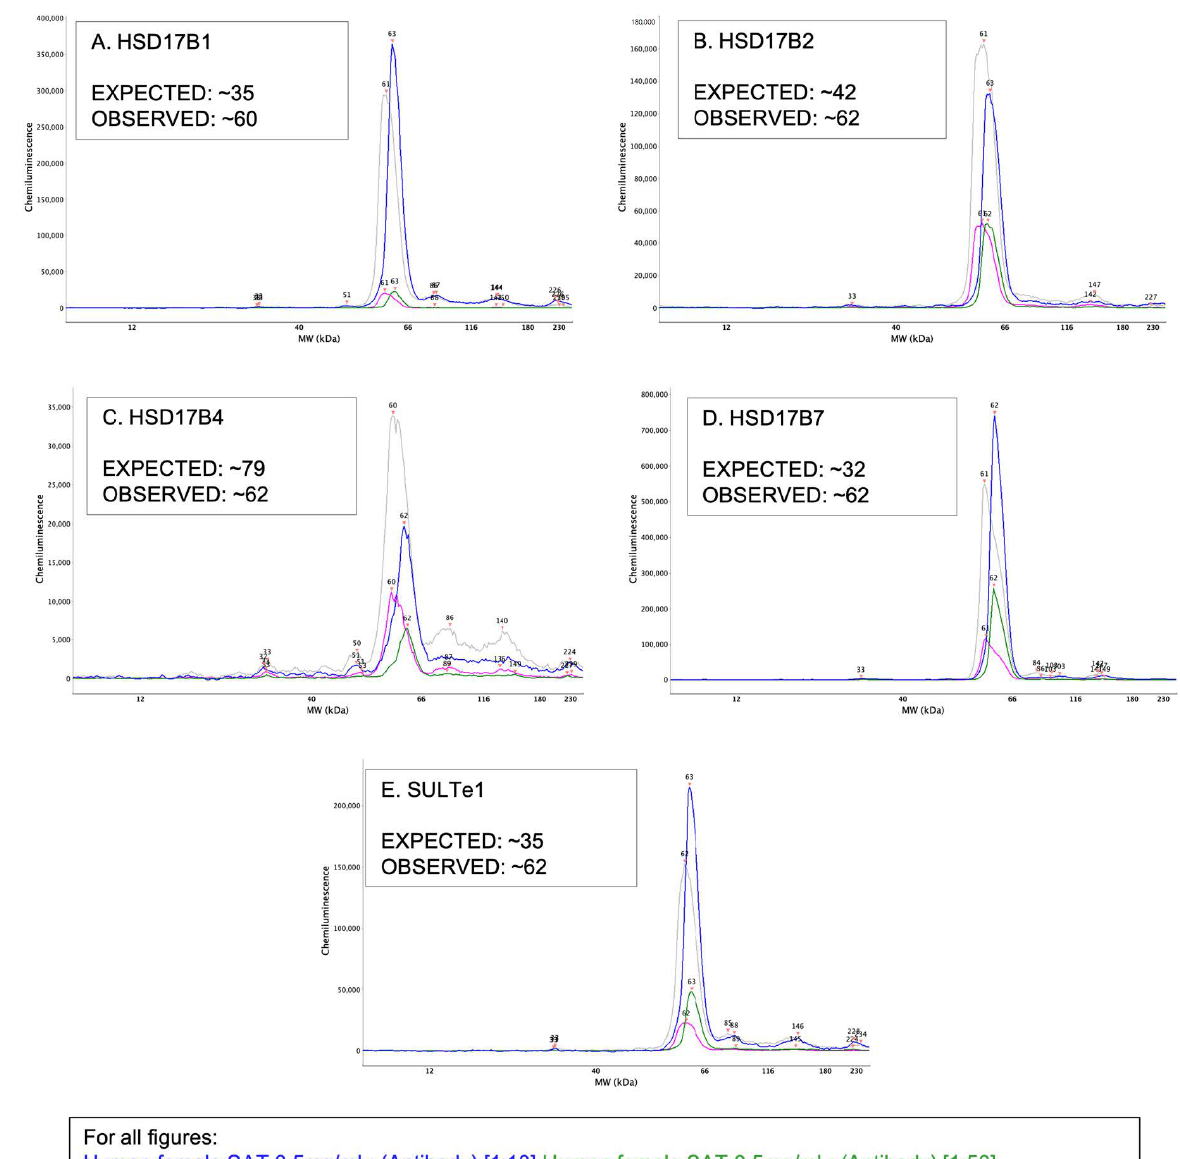
Figure 3. All electropherograms report lysate concentrations of 0.5 and 1.0 mg/mL with 1:10 and 1:50 antibody concentrations. These detection antibodies were not close to their target protein’s predicted molecular weight and were, thus, not considered to be specifically binding target proteins of